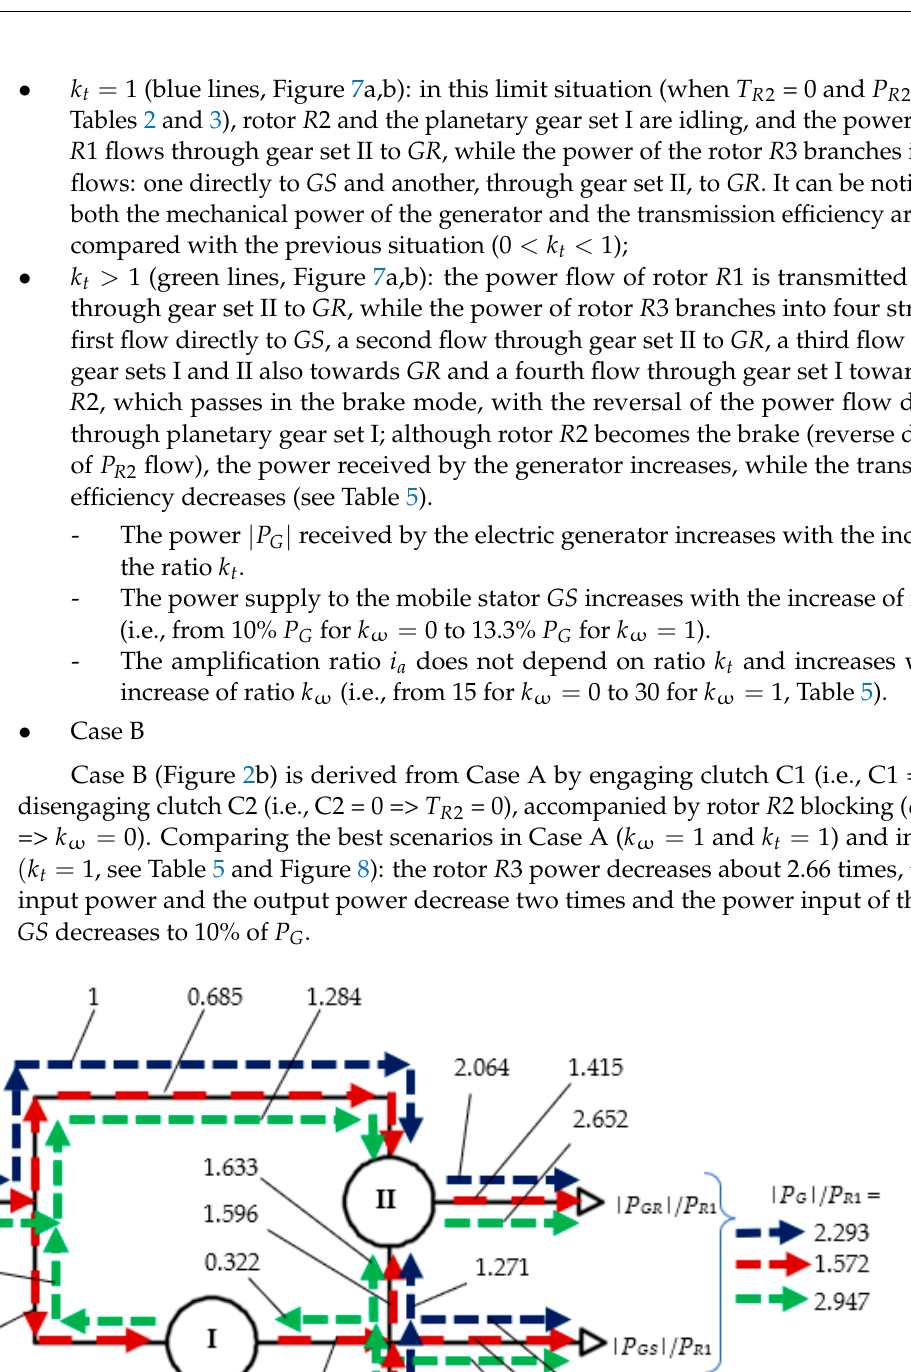
Figure 8. Reduced power flows of the 1-DOF and L = 4 system (Case B) for: k t = 0.5 (red), 1 (blue) and 1.5 (green).